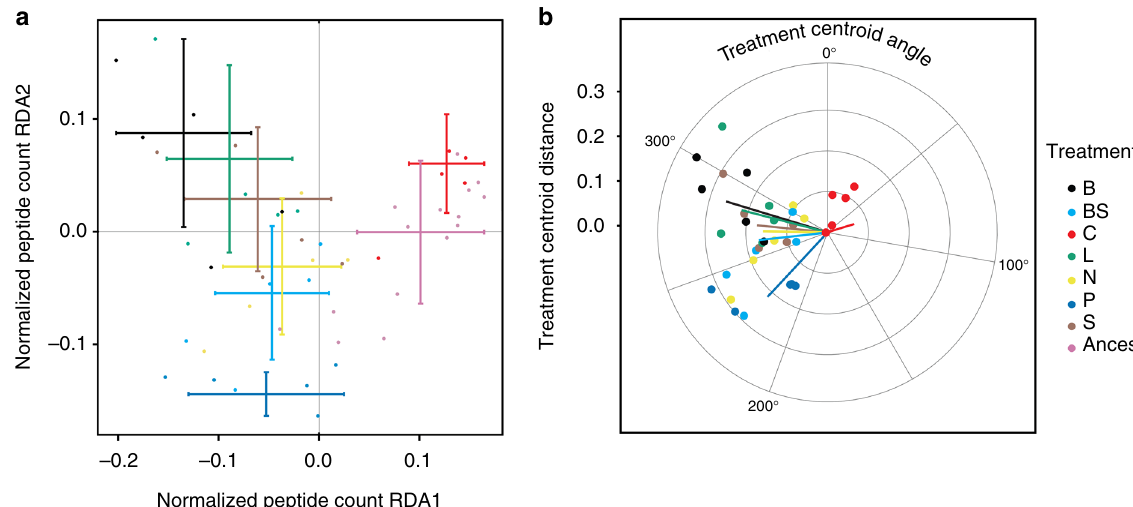
Fig. 1 RDA analysis of protein expression levels explained by treatments and conditioned by population. Protein expression levels include 3347 response variables and consist of 51 independent observations. a The selection treatments cause signi fi cant differences in the protein expression levels (redundancy analysis, RDA; permutational ANOVA; p < 0.001; error bars represent standard errors). The fi rst two RDA axes explain 74% of the total variation (which totals at 0.00586 units). Ancestral and control treatments are separated from the other treatments by Axis 1 (ANOVA; TukeyHSD post hoc test p < 0.01) and the low-phosphate treatment is separated from ancestors, controls, biotic, low-light, and high-salt treatments by Axis 2 (ANOVA; TukeyHSD post hoc test p < 0.01). b The angles and distances of each treatment from the ancestral mean on the RDA plane. All treatments exhibit convergent trajectories with the signi fi cant exception of the control ( p < 0.01; TukeyHSD post hoc